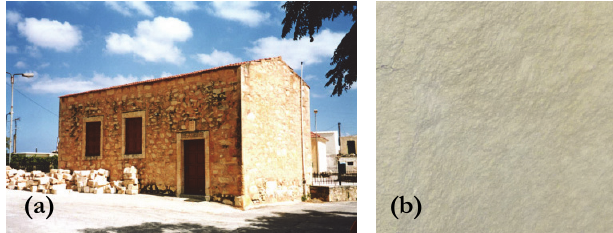
Figure 3: (a) Primary school at Scordilo village made of Alfas stone; (b) The compact texture of Alfas stone.